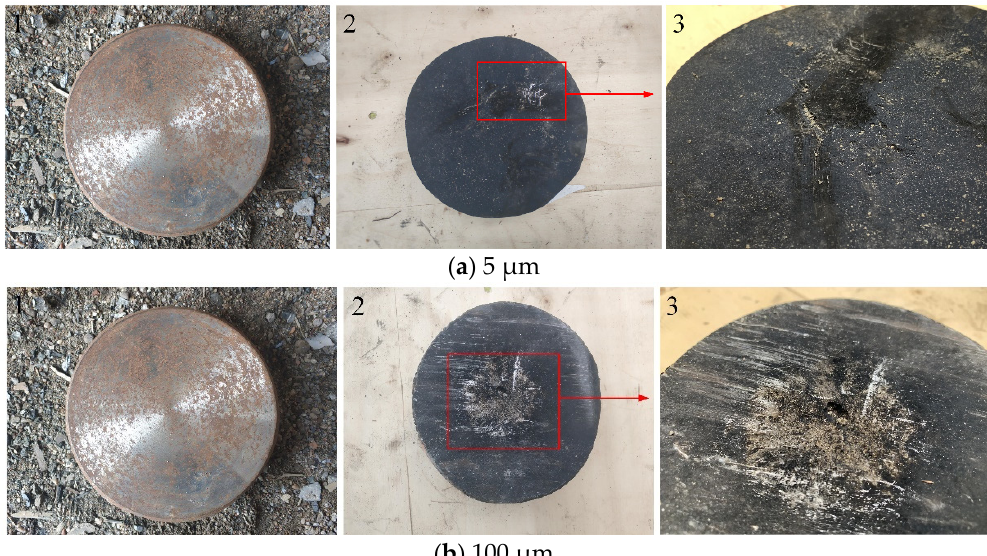
Figure 5. Damage to the witness target.